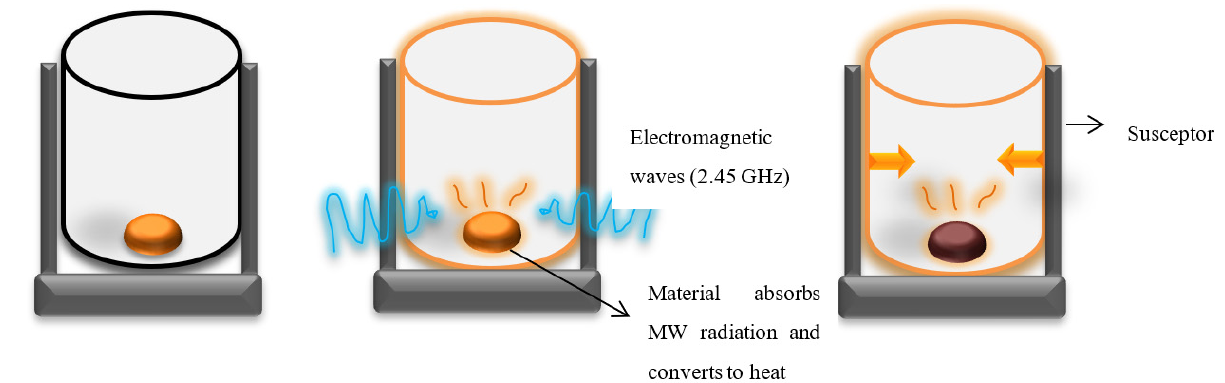
Figure 10. Schematic representation of Microwave sintering.